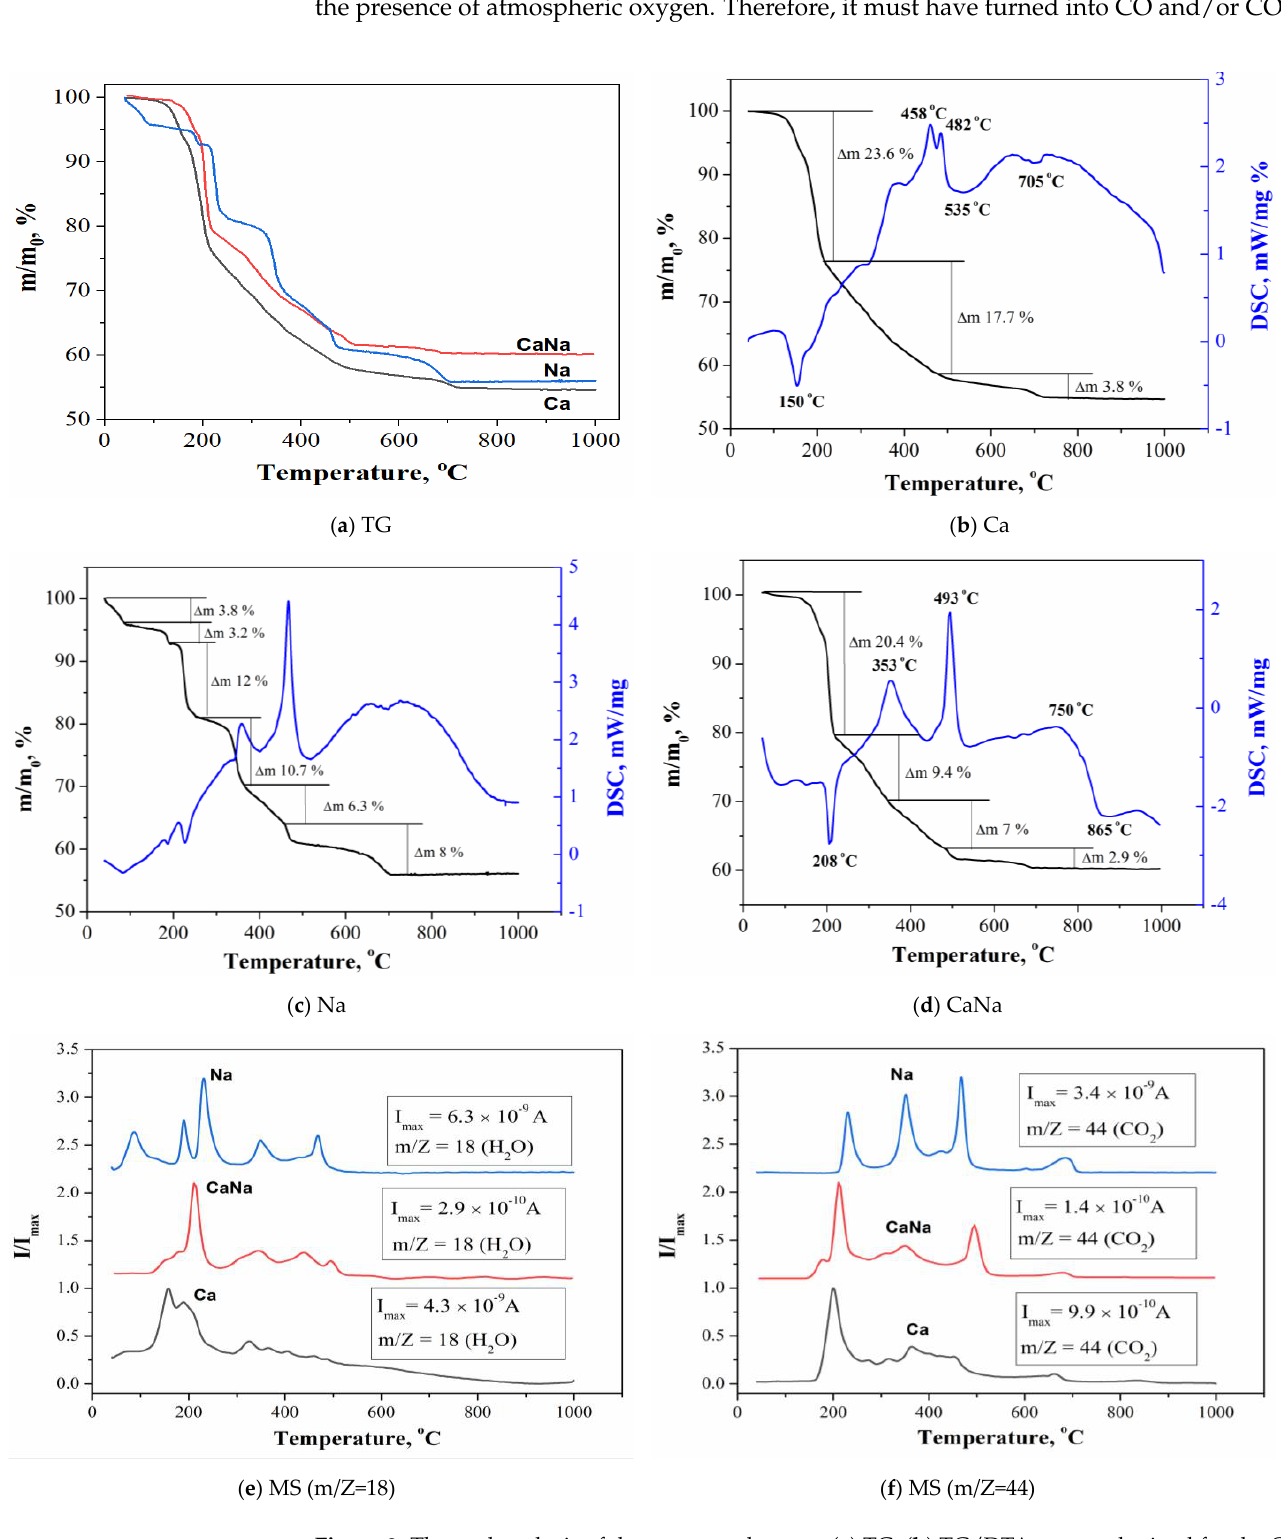
Figure 3. Thermal analysis of the cement-salt stone: ( a ) TG; ( b ) TG/DTA curves obtained for the Ca synthesized powders; ( c ) TG/DTA curves obtained for the Na synthesized powders; ( d ) TG/DTA curves obtained for the CaNa synthesized powders; ( e , f ) ion current curves according to mass spectroscopy for m/Z = 18 (H 2 O) ( e ) and for m/Z = 44 (CO 2 ) ( f ),